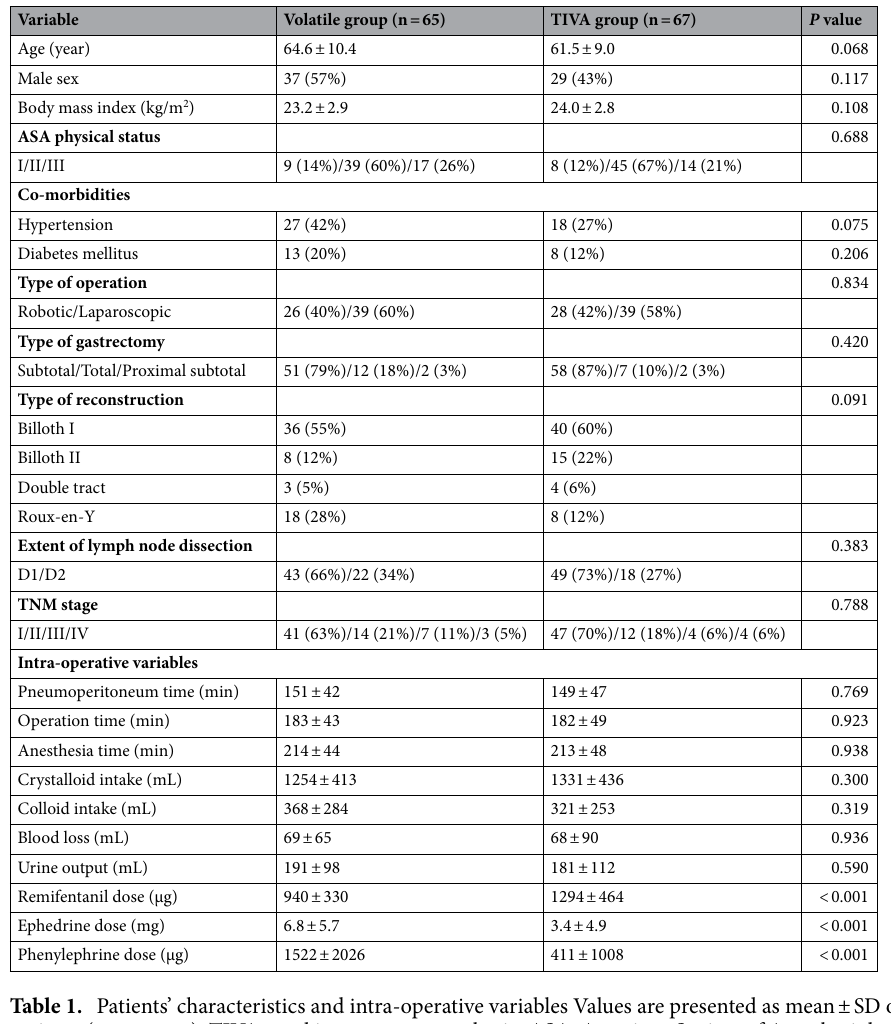
Table 1. Patients’ characteristics and intra-operative variables Values are presented as mean ± SD or number of patients (percentage). TIVA: total intravenous anesthesia; ASA: American Society of Anesthesiologists; TNM: tumor-node-metastasis.